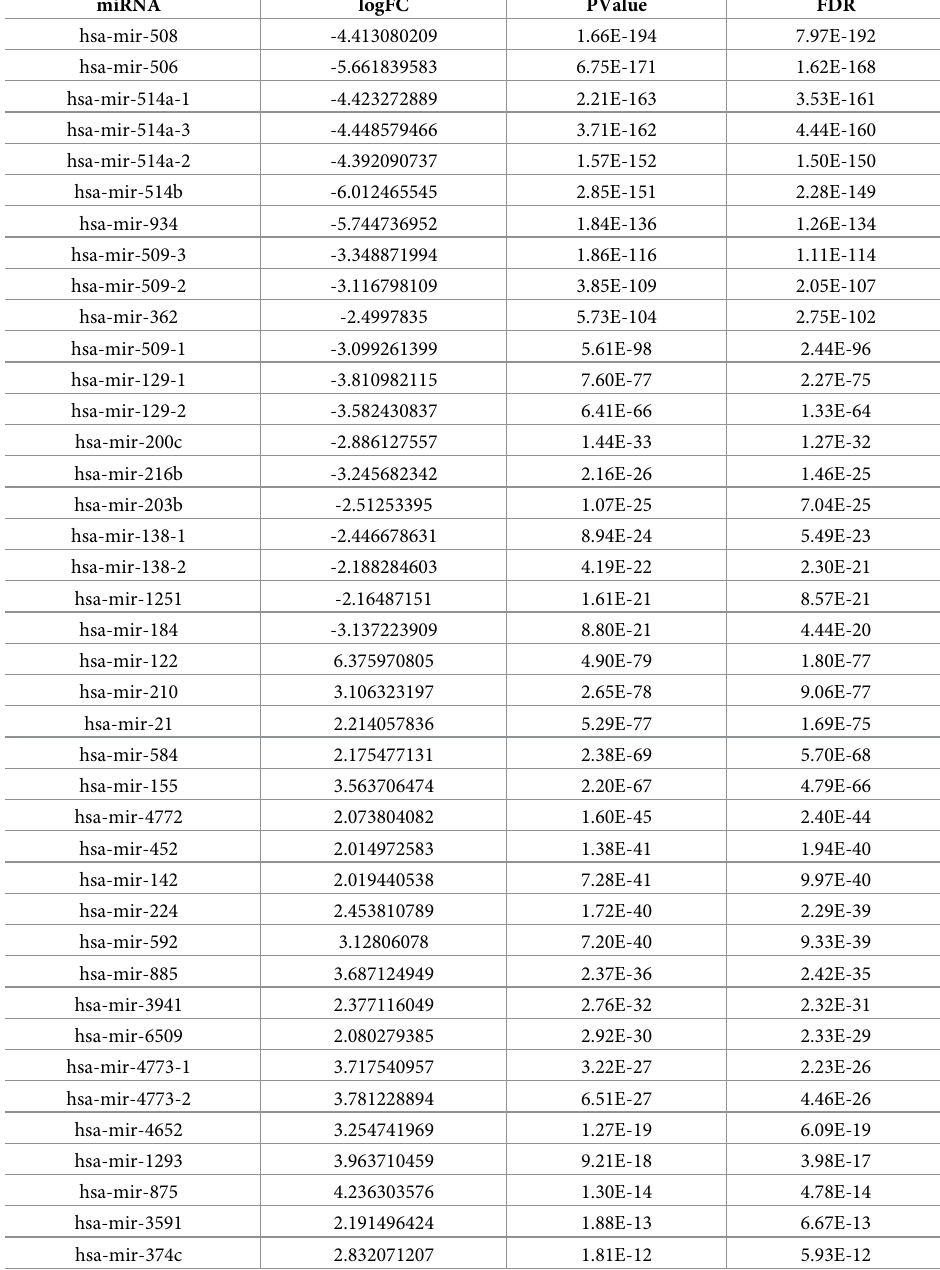
Table 4. Top 20 upregulated and downregulated miRNA in patients with KIRC. miRNA logFC PValue FDR